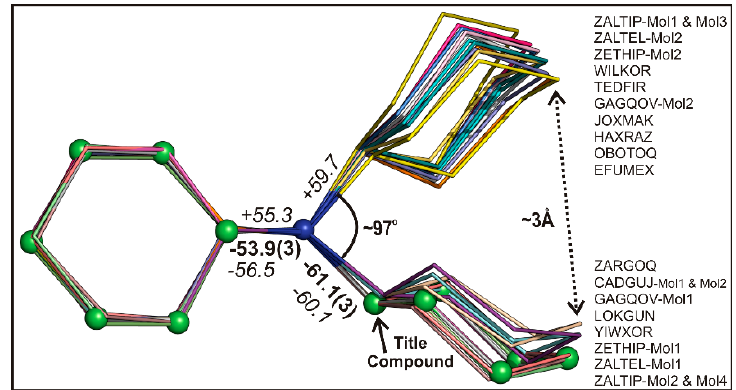
Figure 6. Conformational flexibility of cyclohexyl rings. The cation moiety of the title compound is shown in a ball-and-stick model, and carbon atoms are colored green. The remaining structures are shown in a simple line model. Molecules are marked using CSD REFCODES and molecules with more than one model in the asymmetric unit are marked as Mol1, Mol2, etc. The figure is rendered using PyMOL [22].